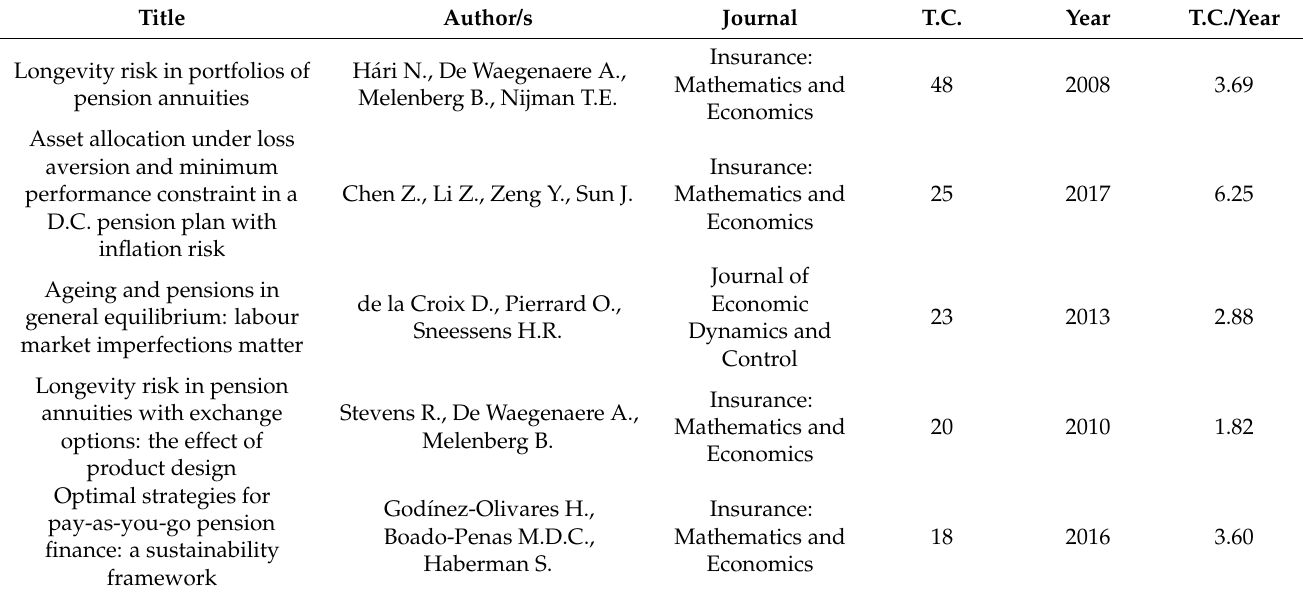
Table 17. The top 5 most cited articles in the Mathematics